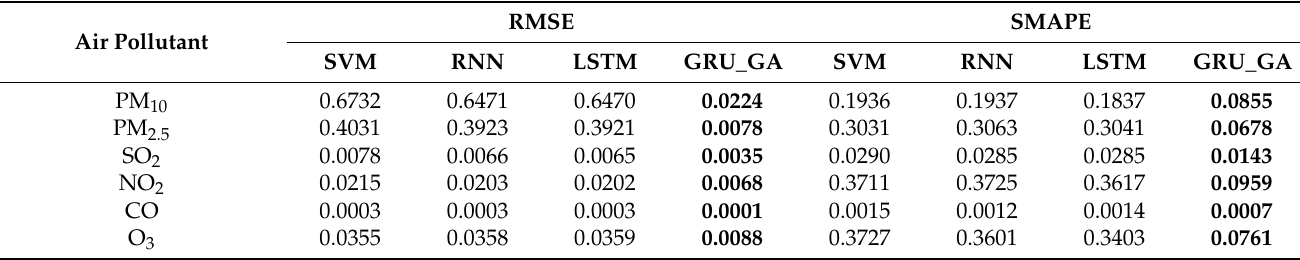
Table 13. The prediction results of GRU_GA compared with other air-quality-prediction methods with Dataset